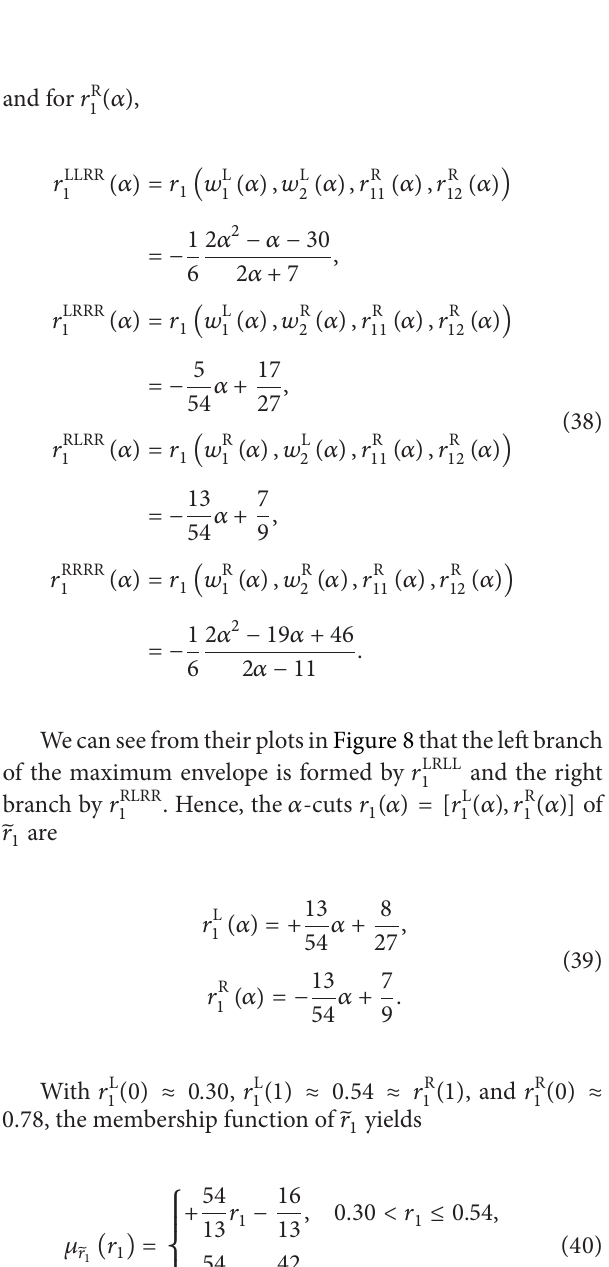
Figure 7: Normalized linguistic variable value scale . VL: very low, L: low, ML: medium low, M: medium, MH: medium high, H: high, and VH: very